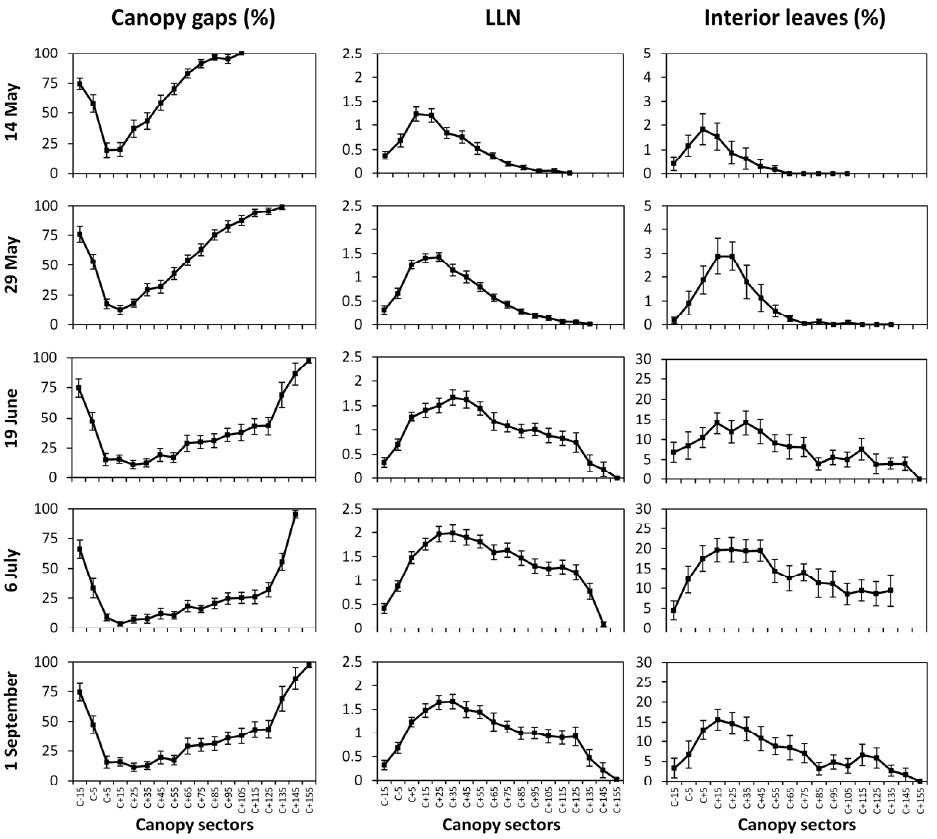
Figure 6. Variation over measuring dates and canopy sectors of the fraction of canopy gaps, LLN and fraction of interior leaves. C ± n indicate distance in cm from the supporting wire held at 70 cm from the ground. Vertical bars indicate standard error, for n = 24.